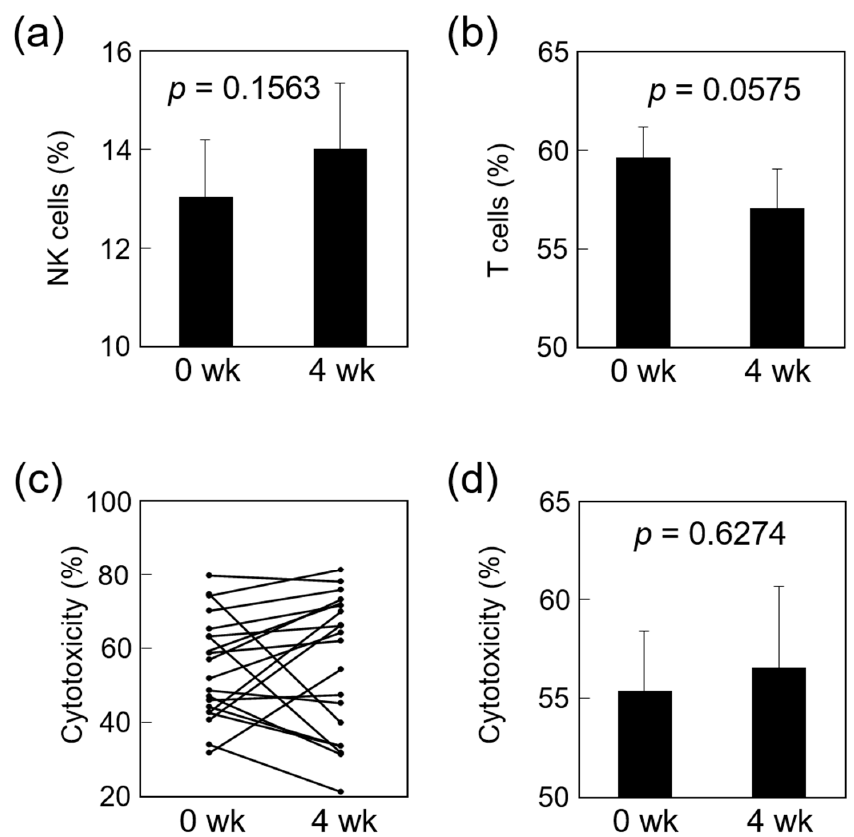
Figure 1. Effect of fermented B. rapa L. on immune cells. Each volunteer ( n = 20) supplemented their diet with fermented B. rapa L. for 4 weeks. Percentages of NK cells ( a ) and T cells ( b ) in PBMC from volunteers analyzed using flow cytometry. NK cell activity was measured against K562 target cells at an E/T ratio of 50 by the 51 Cr-release assay. Changes in NK cell activity in each volunteer ( c ) and mean ± SE ( d ) are shown. Data are mean ± SE. p -value was determined by the nonparametric Wilcoxon signed-rank test between week 0 and week 4.